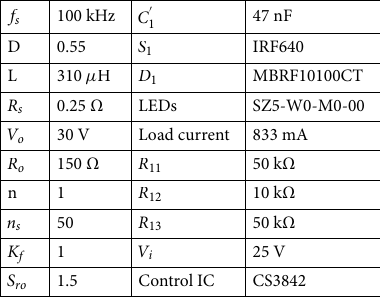
Table 1. Components and system parameters used in the experiment.